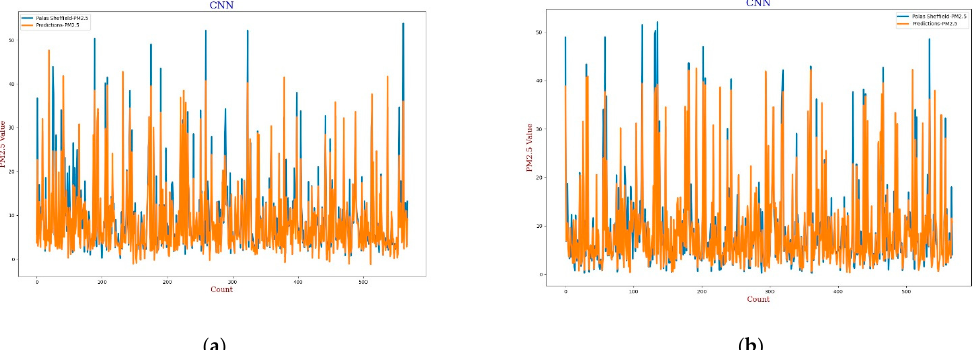
Figure 13. ( a ) CNN calibration plot for PM 2.5 using AH . Blue colour represents the reference data and orange colour represents the calibrated data; ( b ) CNN calibration plot for PM 2.5 using RH . Blue colour represents the reference data and orange colour represents the calibrated data.